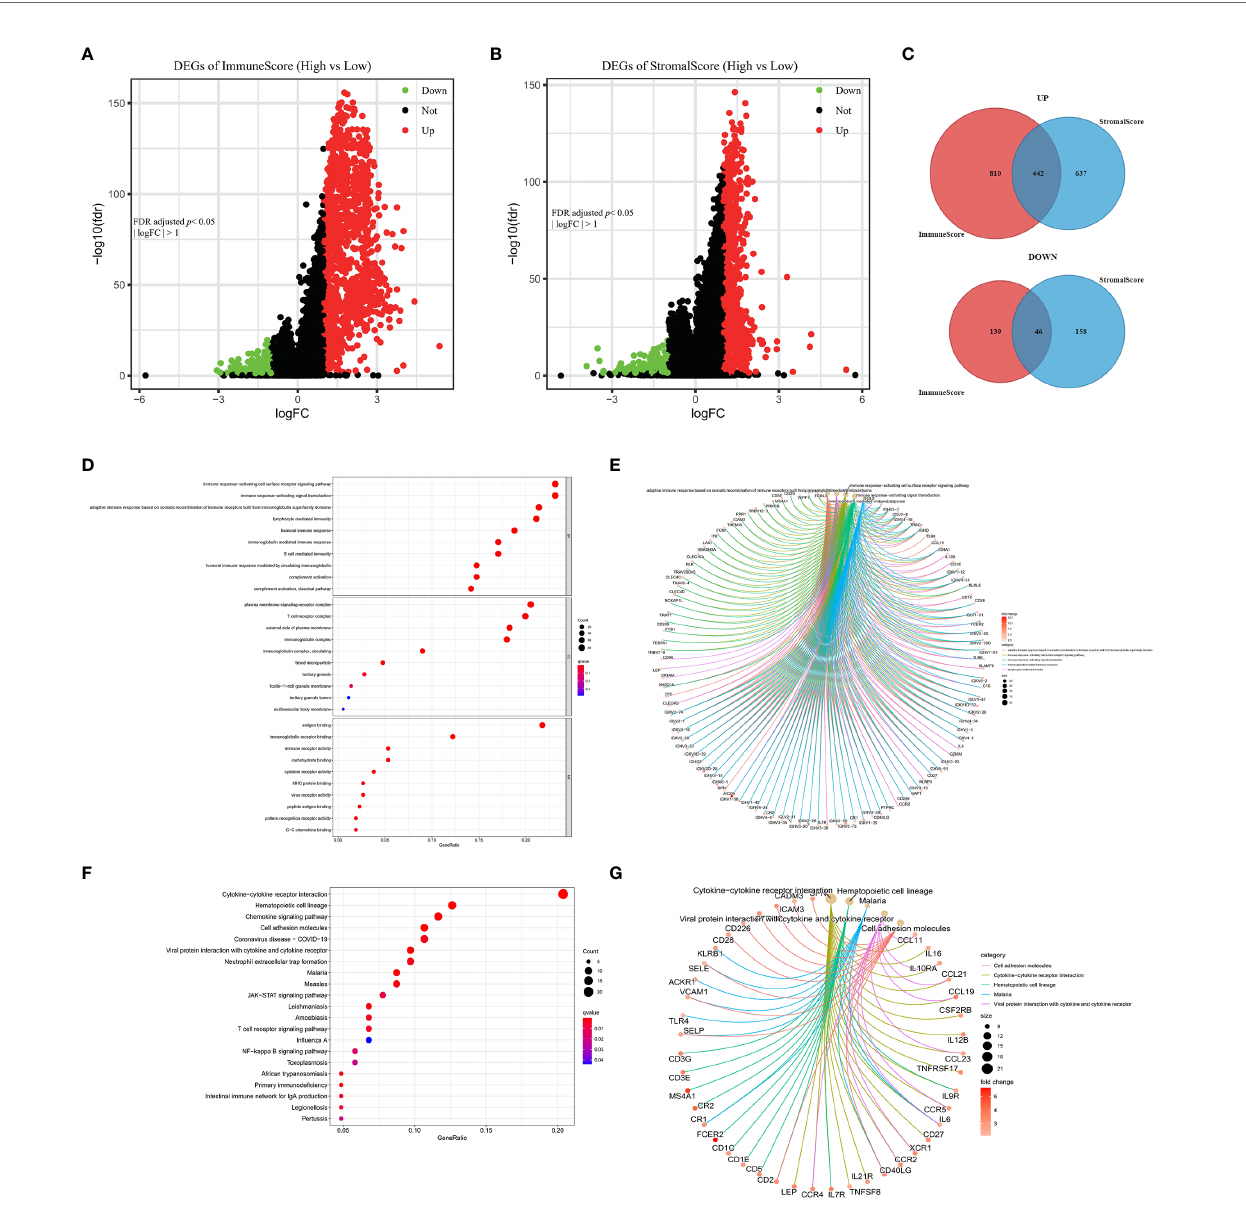
FIGURE 4 | Volcano plots, Venn diagrams, and GO and KEGG enrichment analyses of differentially expressed genes (DEGs). Volcano plots of signi fi cant DEGs (FDR-adjusted p < 0.05, |log FC| > 1) between high and low (A) ImmuneScore and (B) StromalScore groups. (C) Venn diagrams of upregulated and downregulated DEGs that were shared by the ImmuneScore and StromalScore analyses. (D, E) GO and (F, G) KEGG enrichment analyses ( p < 0.05 and q <